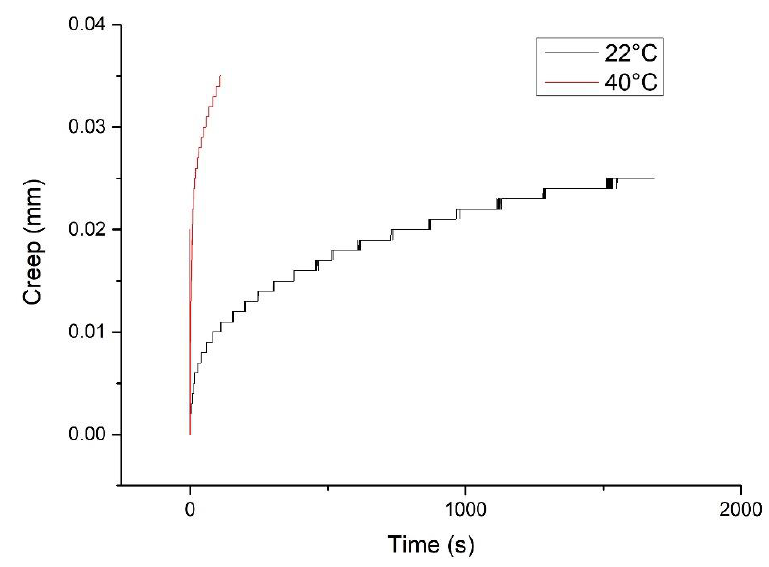
Figure 8. The 22 °C and 40 °C compressive creep curve of the prepreg sample. Figure 8. The 22 ◦ C and 40 ◦ C compressive creep curve of the prepreg sample.